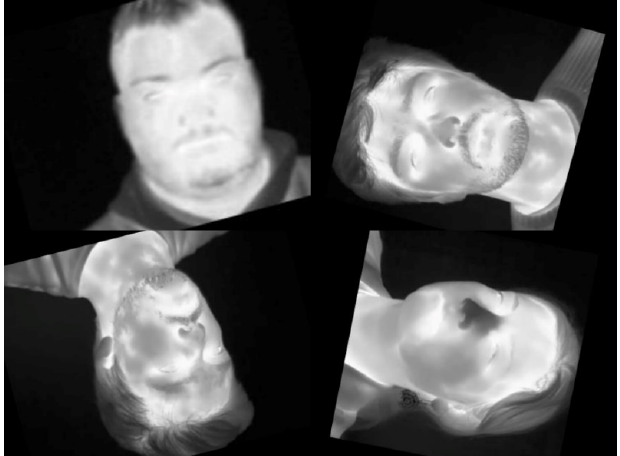
Figure 4. Examples of the augmented images.